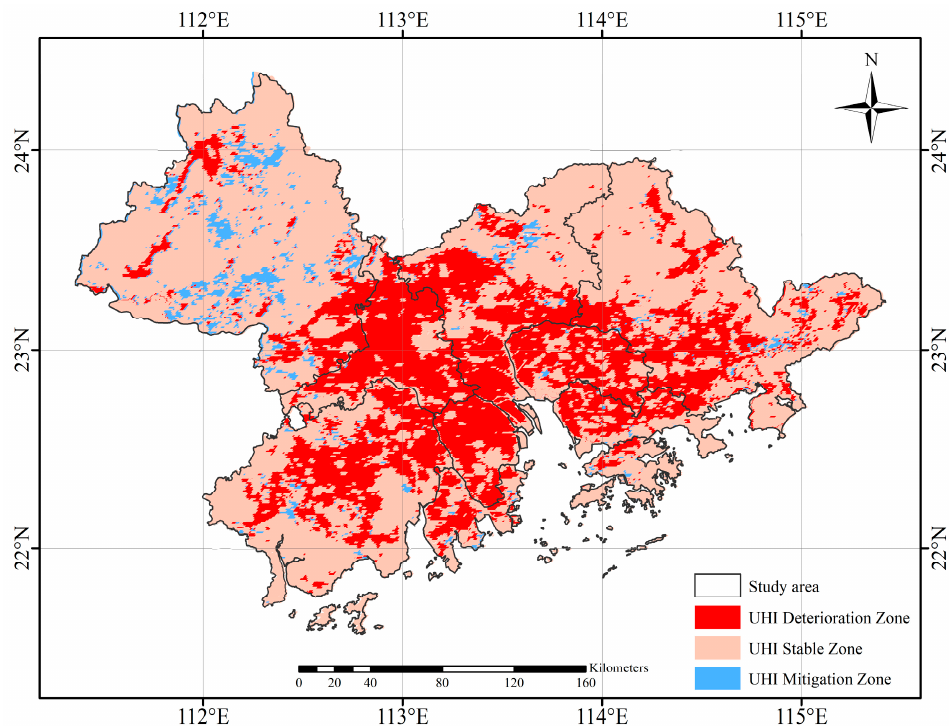
Figure 8. GBA heat island intensity monitoring index changes from 2000~2020.